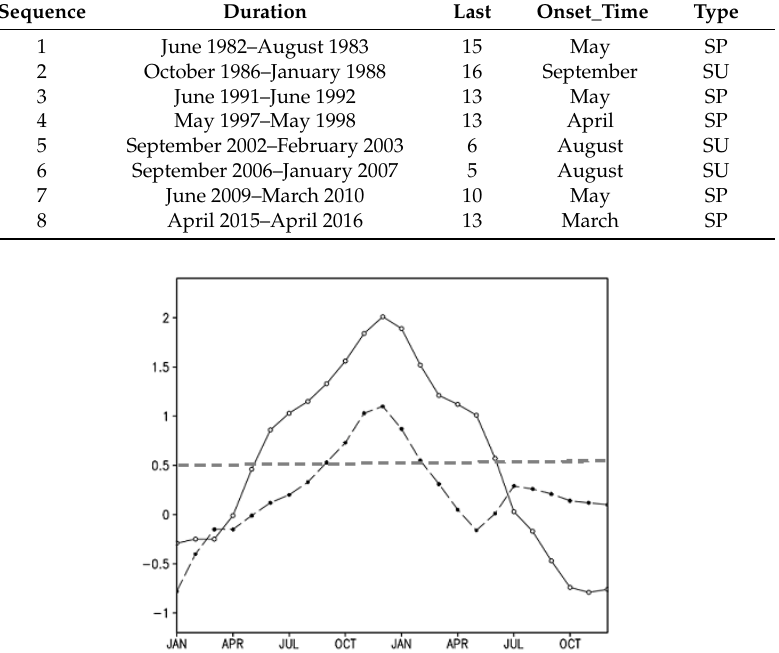
Figure 1. Composite time series of SST anomaly (unit: °C) for spring (open circles) and summer (solid circles) El Niño events during 1979–2016.